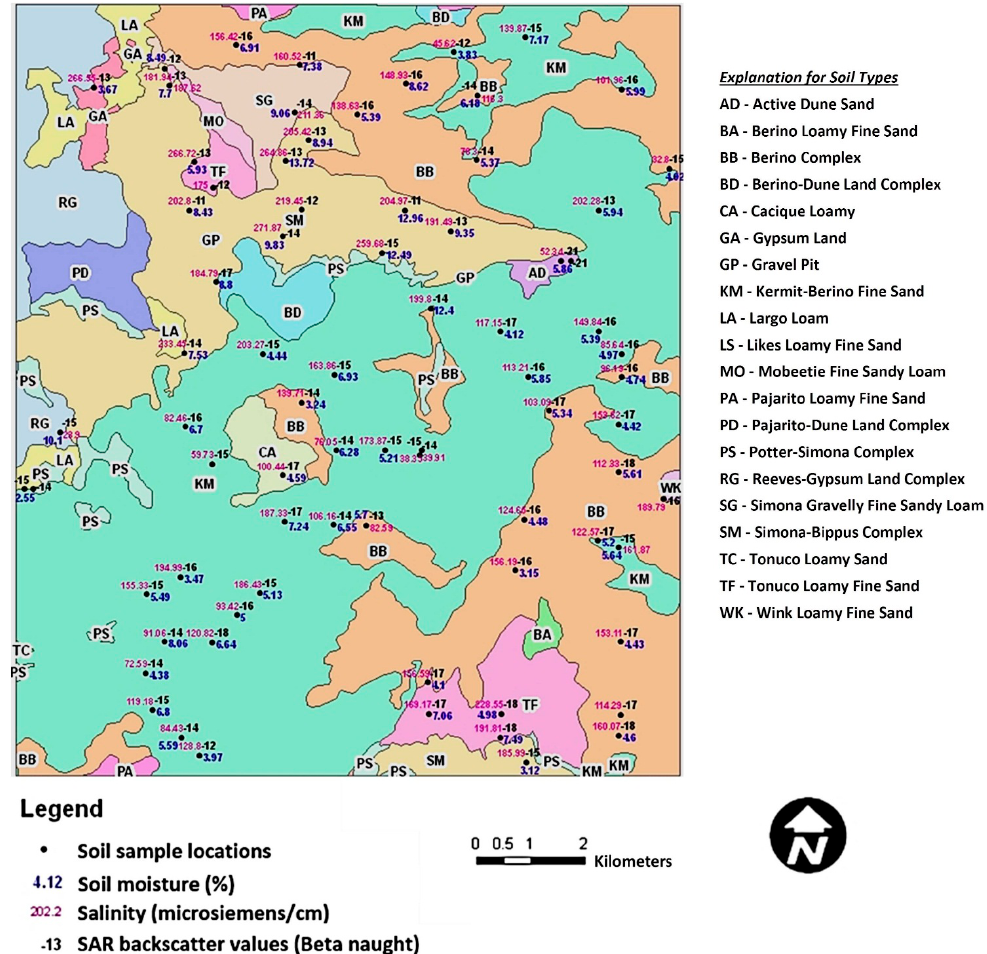
Figure 6. Measurements of soil moisture, soil salinity, and radar backscatter values shown on different soil types in Nash Draw (August 2006 data set).